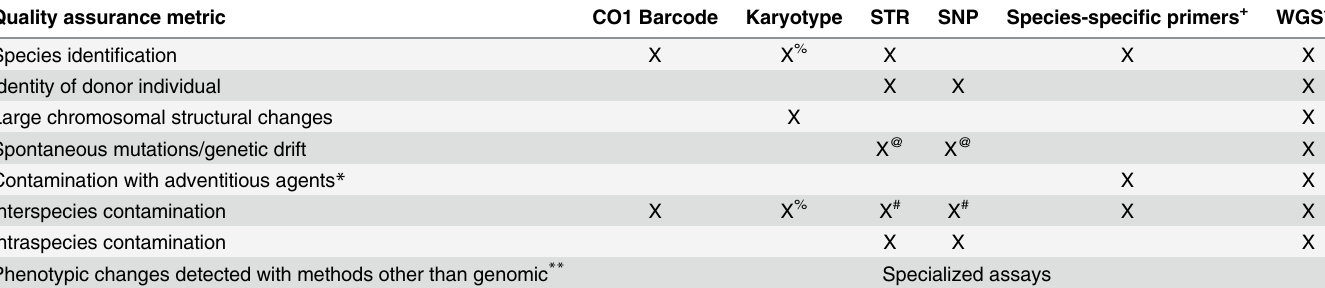
Table 1. Some commonly used methods applicable for assessing quality of cell